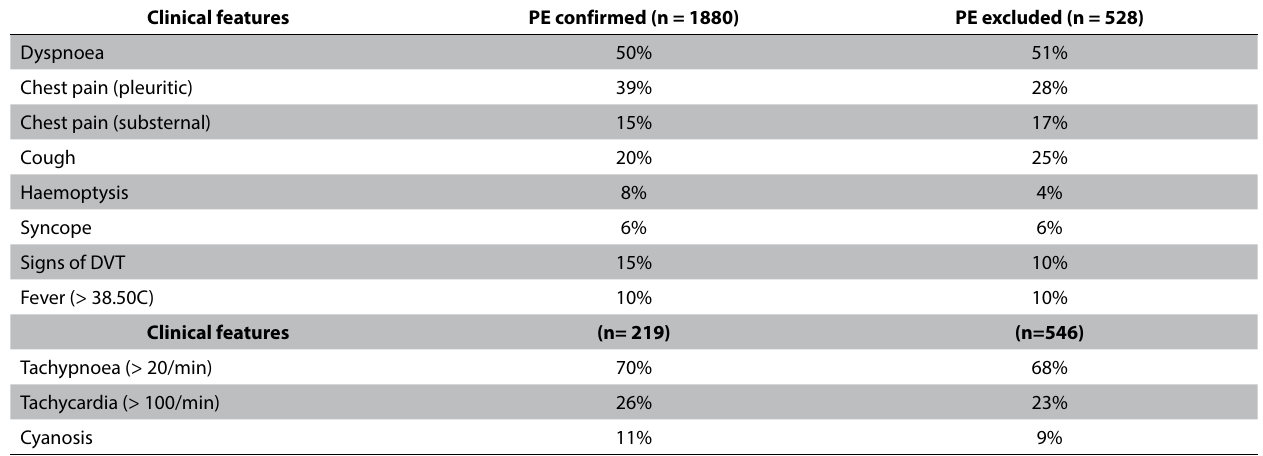
Table 1: Prevalence of symptoms and signs in patients with suspected PE according to final diagnosis 1,5 Clinical features